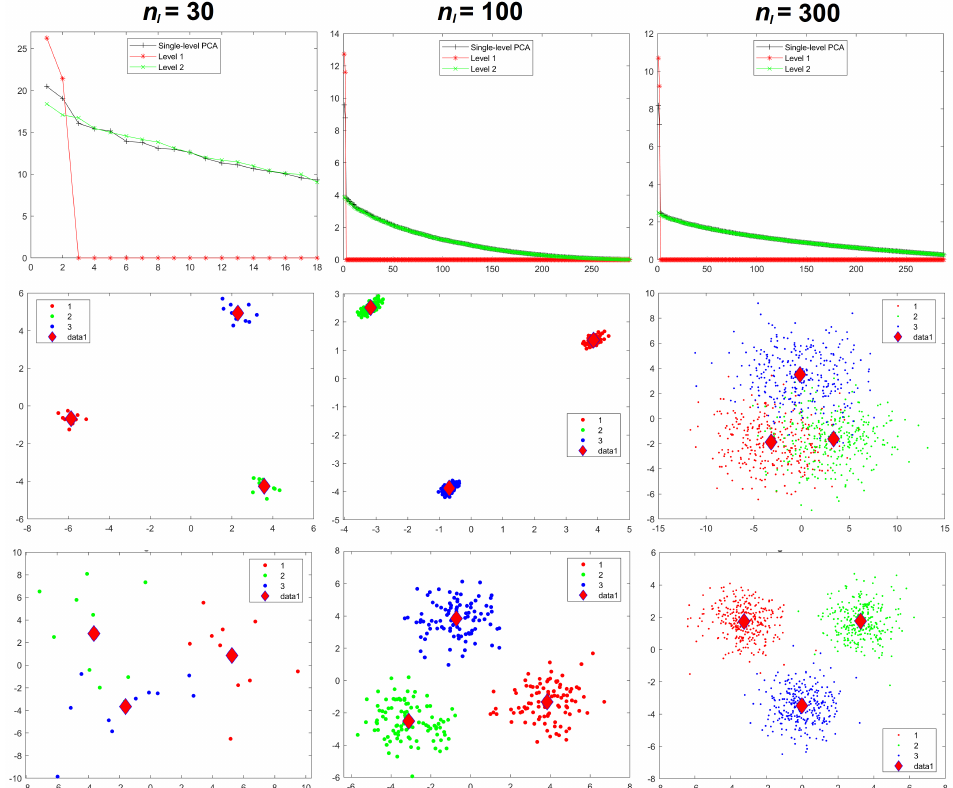
Figure 7. Experiment 3: eigenvalues ( upper row ), mPCA, level 1 component scores ( middle row ), and single-level PCA, component scores ( bottom row ) for sample sizes per group of n l = 10 ( left- hand column ), n l = 100 ( middle column ), and n l = 300 ( right-hand column ) in all groups l = 1,2, 3. Between-group variation has been added in this case and so component scores should be strongly separated for all values of n l . Group centroids are shown by the diamonds; x -axis = first component; y -axis = second